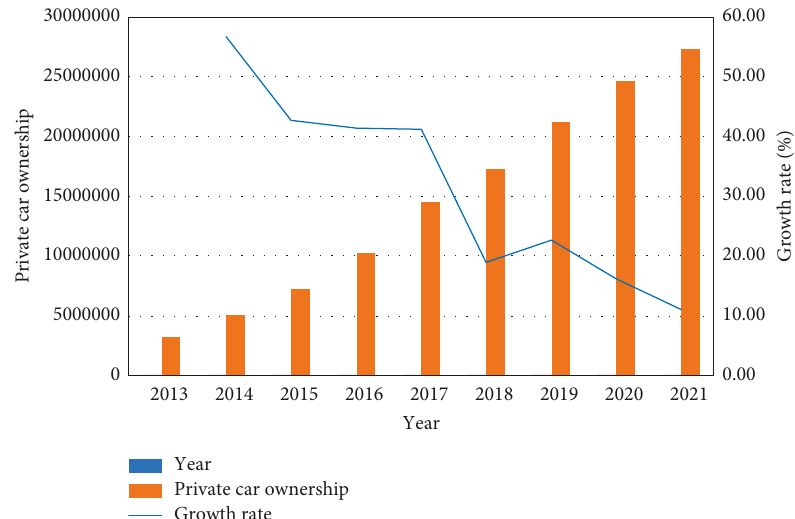
Figure 1: Private car ownership from 2013 to 2021 in